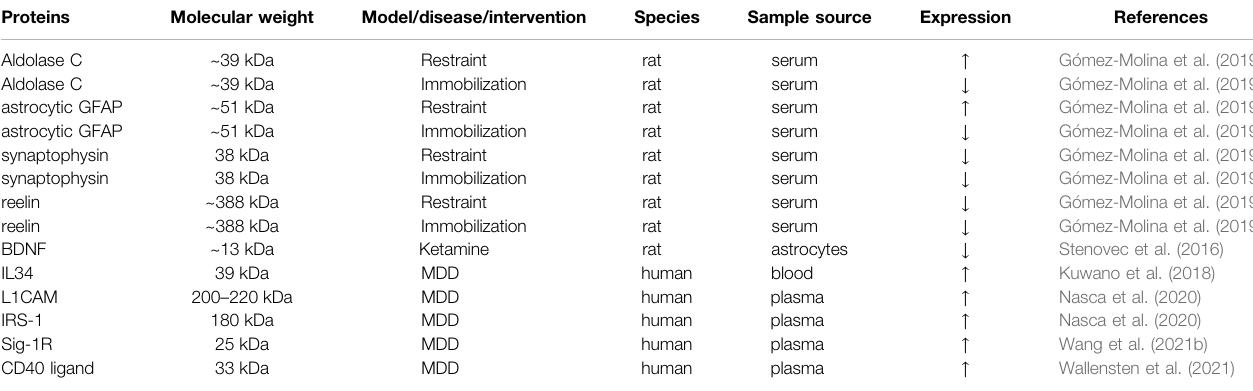
TABLE 2 | EV-associated proteins and their potential targets in DD.